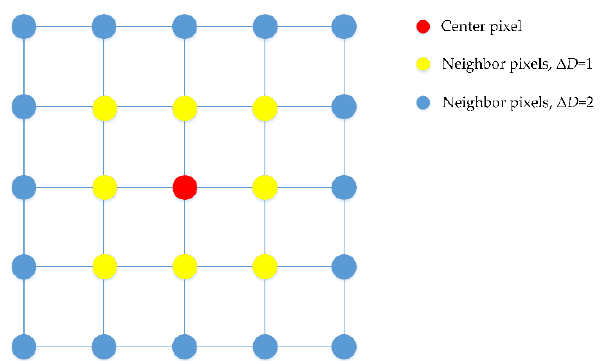
Figure 7. Neighbor pixels within Δ D .